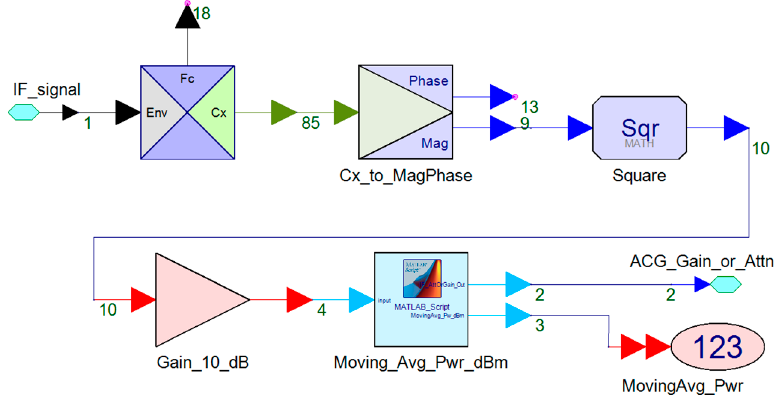
Figure A8. Moving average IF signal power measurement.